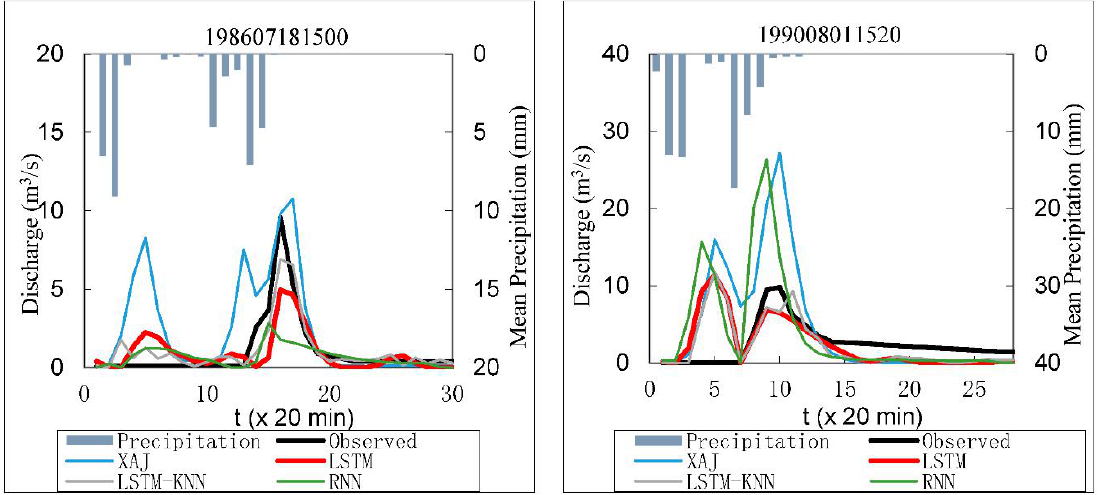
Figure 7. Two observed and estimated hydrographs using four models (XAJ, LSTM, LSTM-KNN, RNN) in Xianbeigou Catchment.